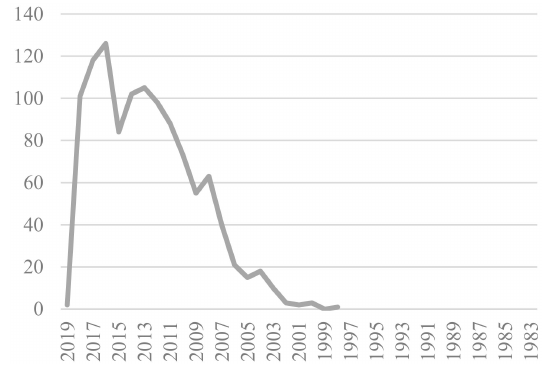
Figure 4. Evolution of scientific research on renewable energy associated to green building.